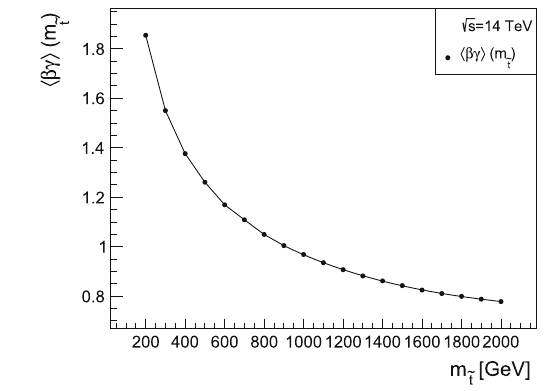
Fig. 44 Average value of the Lorentz factor βγ of the stop squark